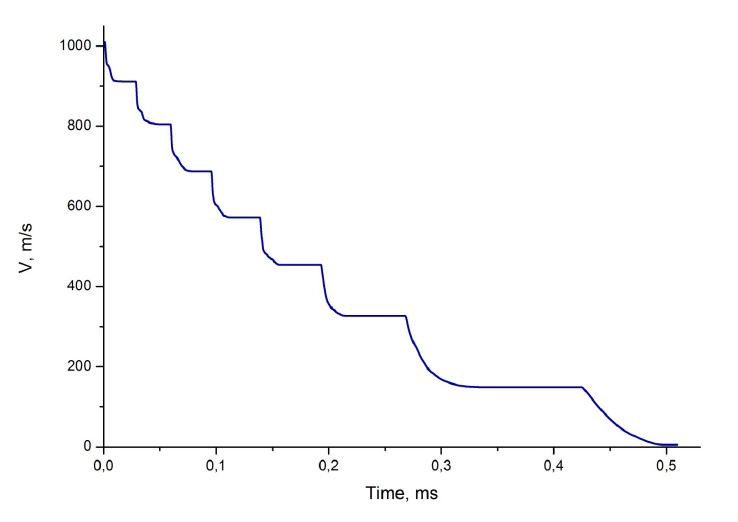
Figure 6. Time variation of center-of-mass velocity of